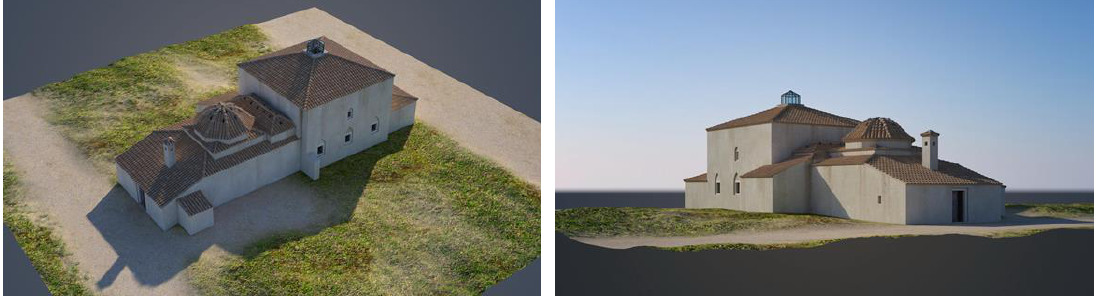
Figure 5. Reconstruction of the Ottoman bath.